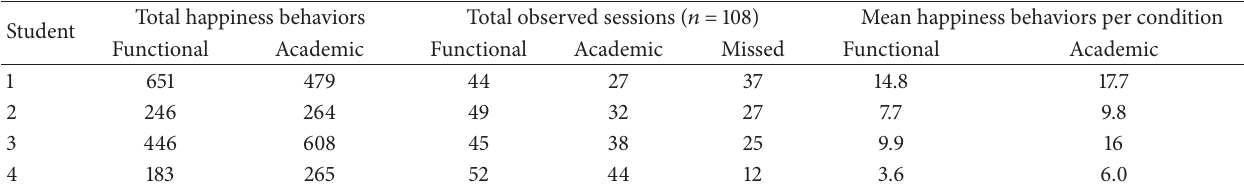
Table 3: Mean occurrence of behaviors associated with happiness per instructional